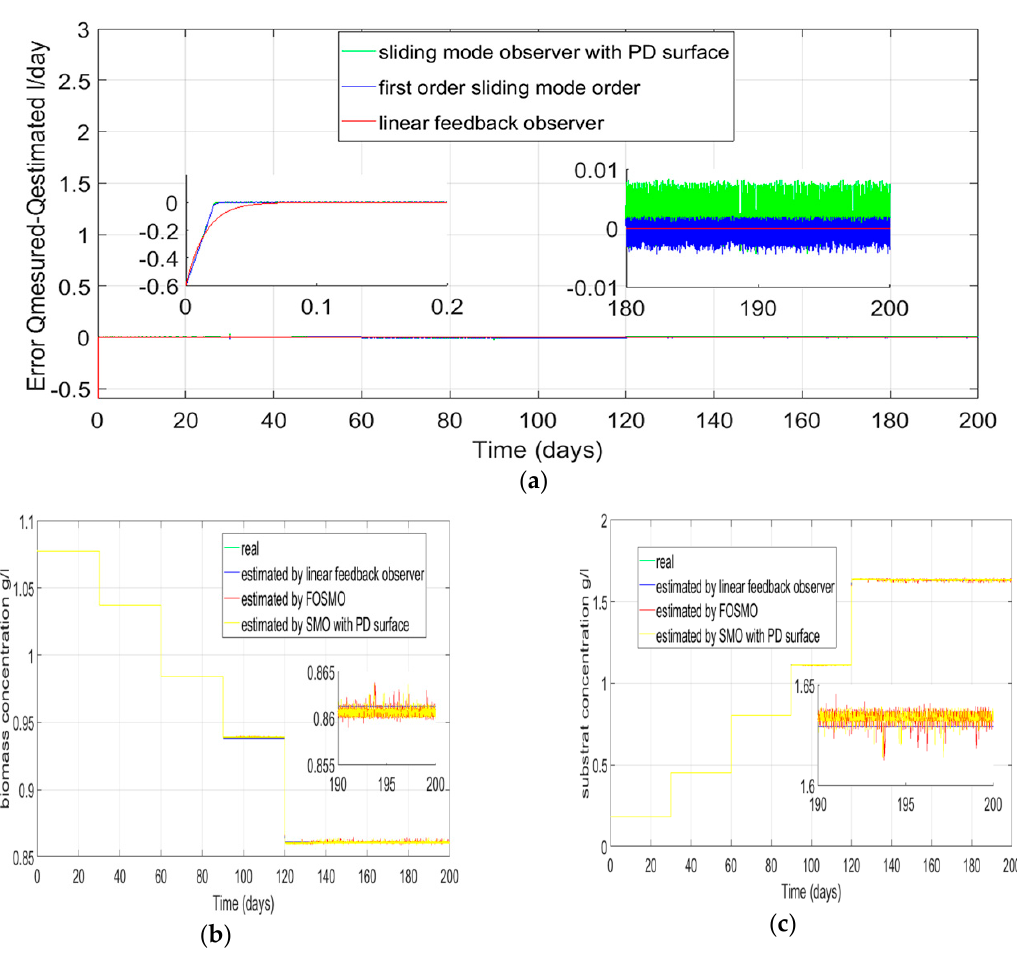
Figure 8. Comparison between three observers ( a ) Error evolution of biogas flow rate measured, and biogas flow rate estimated with the virtual sensors; ( b ) evolution of the real biomass and estimated biomass with three observers; ( c ) evolution of the real substrate and estimated substrate for three observers.